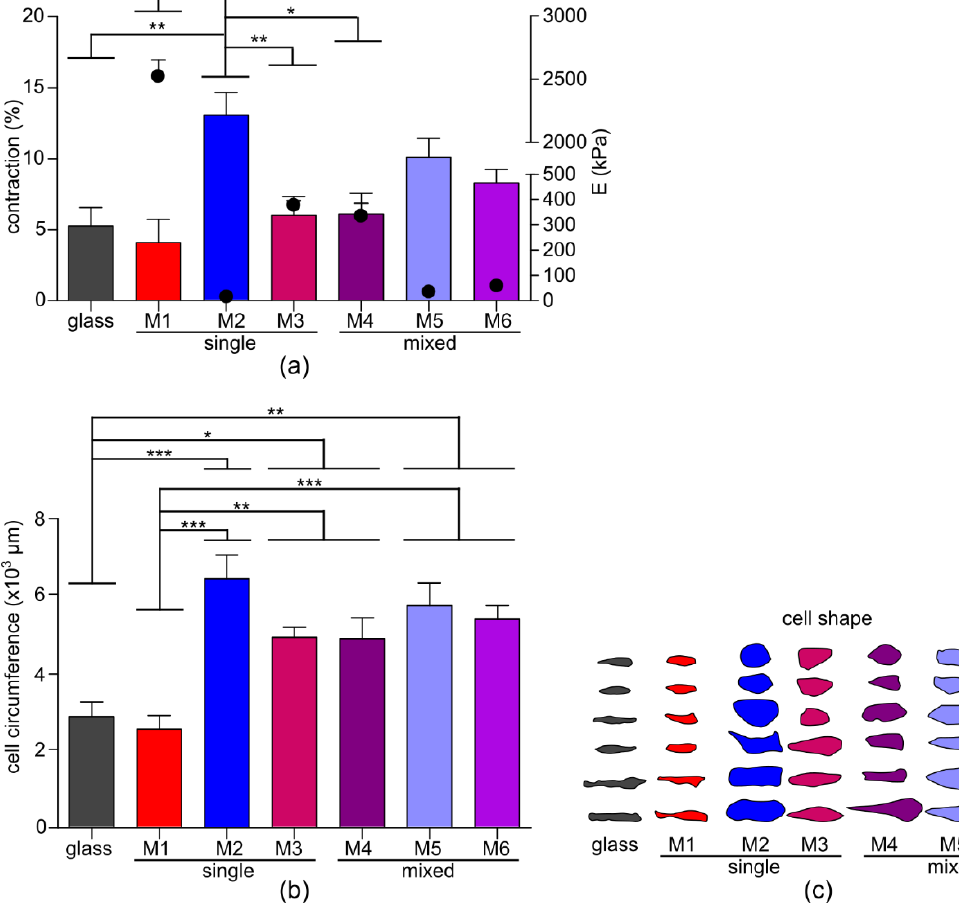
Figure 4. Cardiomyocyte (CM) contraction behavior and shape. ( a ) Degree of contraction of the CMs (bars, left Y-axis) in relation to the Young’s modulus (dots, right Y-axis) shows an increased contraction for a decreased Young’s modulus. ( b ) Cell-spreading circumference of the relaxed CMs is significantly lower for the stiff substrates glass and PTMC (M1). ( c ) Shape as defined by the CM circumferences. * p < 0.05, ** p < 0.01, *** p < 0.001.